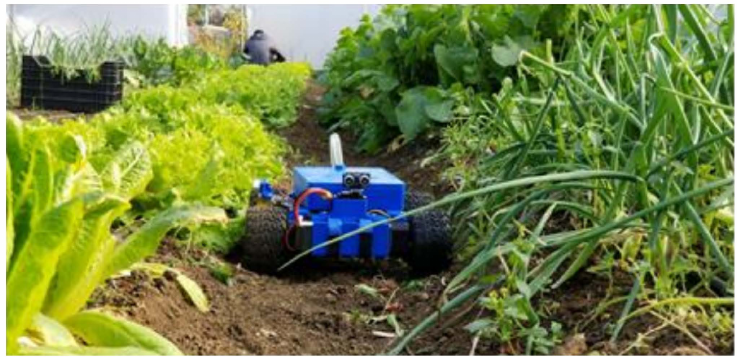
Figure 15. X-Bot operating in a field [75].